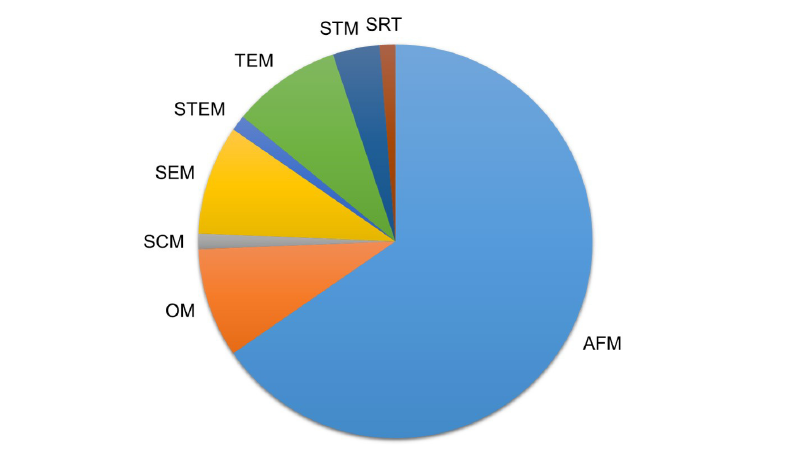
Figure 1. Usage ratio of different characterization methods in thin film analysis reported in the literature (1990–2021). The full name of all the methods can be referred to the list of